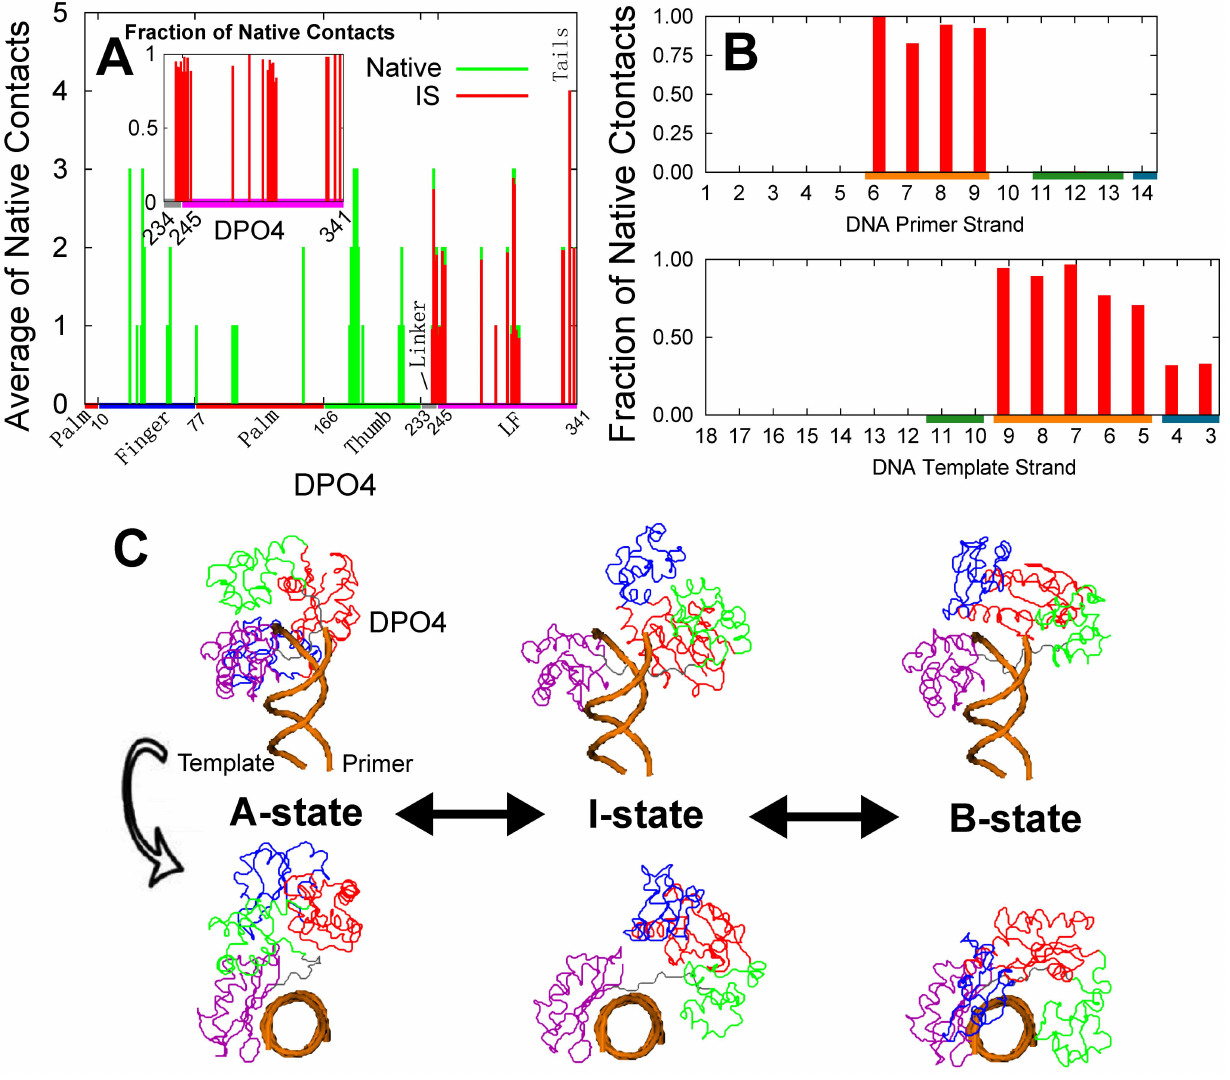
Figure 4. Native contacts between DPO4 and DNA as well as the structural illustrations of DPO4-DNA complex in the IS. (A) The average of inter-chain native contacts for each residue in DPO4 are shown. The fraction of native contacts, which measures the degree of the formation of the native contacts, is shown in the insert figure. (B) The fraction of native contacts is shown for each nucleotide of either the primer or the template strand. The color on the x-axis in (A) and (B) is the same as that in Figure 3. (C) Typical structures of the A-, I- and B-state of DPO4 binding with DNA in the IS are shown. The coloring strategy for DPO4 is the same as that in Figure 1A.